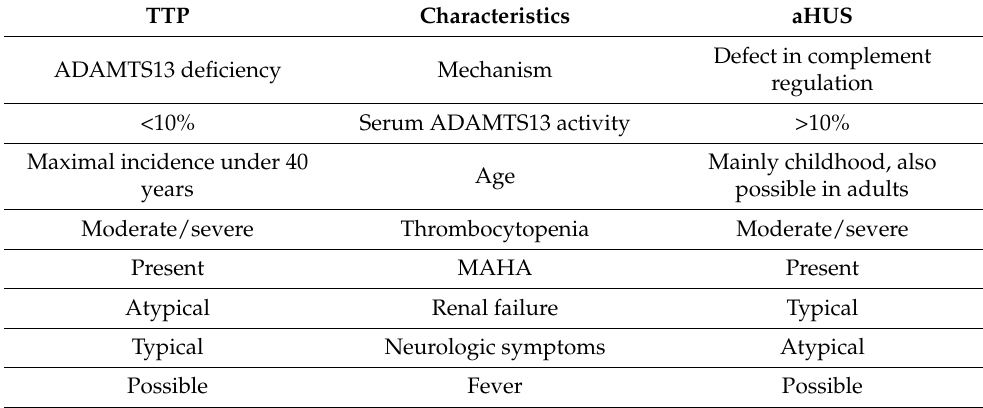
Table 7. Clinical particularities of TTP and aHUS according to Scully and Goodship, 2014